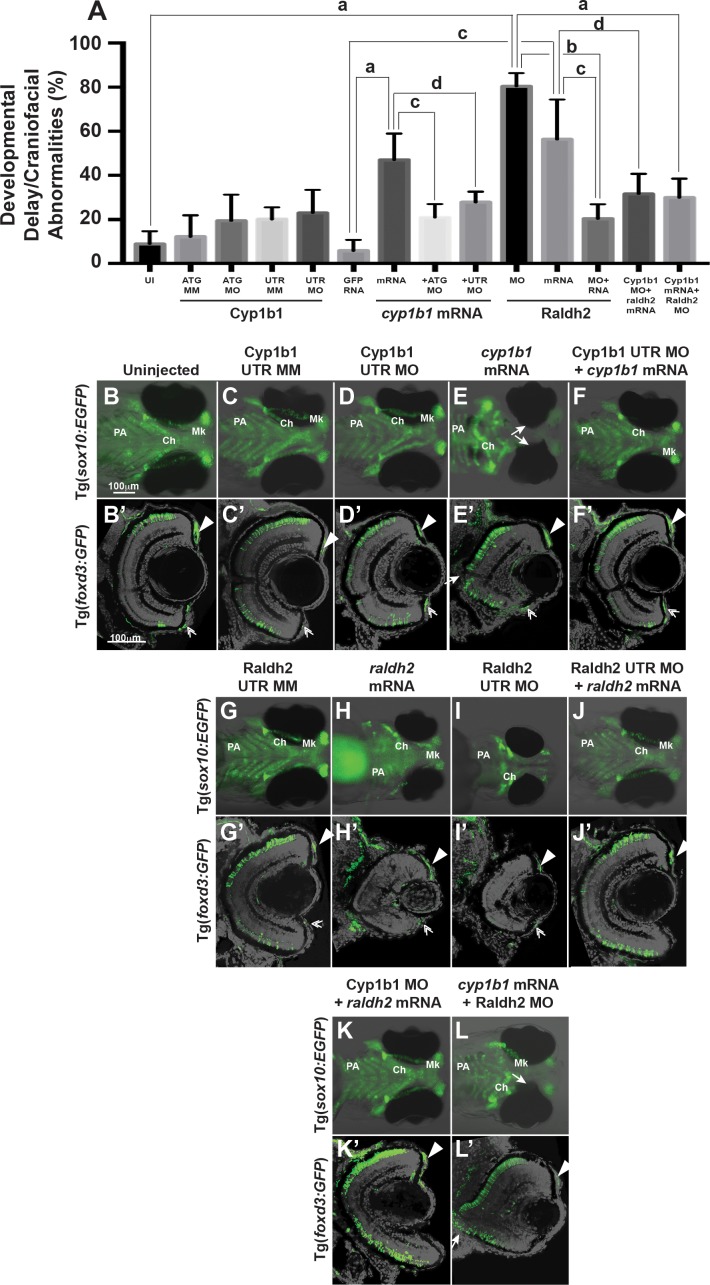
Overexpression of cyp1b1 inhibited ocular fissure closure via an RA-independent pathway. The percentage of 72 hpf embryos with developmental delay and/or craniofacial abnormalities (A) due to Cyp1b1 MO (ATG or 5′ UTR) knockdown, cyp1b1 (mRNA) overexpression, Raldh2 MO knockdown, raldh2 (mRNA) overexpression compared to uninjected, mismatch (MM) MO-injected or gfp mRNA-injected controls. ([a] P < 0.0001; [b] P < 0.001; [c] P < 0.01; [d] P < 0.05). Live images of uninjected (B) and mismatch control-injected (C, G) Tg(sox10:EGFP) embryos showed that at 96 hpf, neural crest contributed to the pharyngeal arches (PA) and the ceratohyal (Ch) and Meckel's (Mk) cartilage of the jaw. Sections of 96 hpf Tg(foxd3:GFP) embryos showed that foxd3-positive neural crest cells contributed to the iris stroma in the dorsal (B', C', G', arrowhead) and ventral (double arrowhead) iridocorneal angle. In addition, differentiated retinal photoreceptors expressed foxd3, which was unrelated to neural crest cells. Injection of 5′ UTR Cyp1b1 MO had minimal effect on craniofacial neural crest (D) and overall eye (D') development. Overexpression of cyp1b1 through mRNA injection disrupted neural crest–derived Meckel's cartilage formation (E, K) and inhibited ocular fissure closure, resulting in prominent colobomas (closed arrows, E, E'). The retinal layers were properly differentiated, including the expression of foxd3. Injection of Cyp1b1 5′ UTR MO improved the ocular and neural crest phenotypes due to cyp1b1 mRNA (F, F'). As previously demonstrated, increasing (raldh2 mRNA, H, H') or decreasing (Raldh2 5′ UTR MO, I, I') RA inhibited pharyngeal arch development, disrupted ceratohyal and Meckel's cartilage formation, and decreased eye size. Injection of raldh2 mRNA rescued the ocular and neural crest phenotypes induced through Raldh2 5′ UTR MO knockdown (J, J'). Cyp1b1 MO improved eye size, retinal differentiation, and neural crest–derived pharyngeal arch and ceratohyal and Meckel's cartilage formation in embryos injected with raldh2 mRNA (K, K'). Knockdown of Raldh2 improved neural crest–derived pharyngeal arch and ceratohyal and Meckel's cartilage formation (L'), but did not rescue ocular fissure closure (arrows, L') in embryos injected with cyp1b1 mRNA.